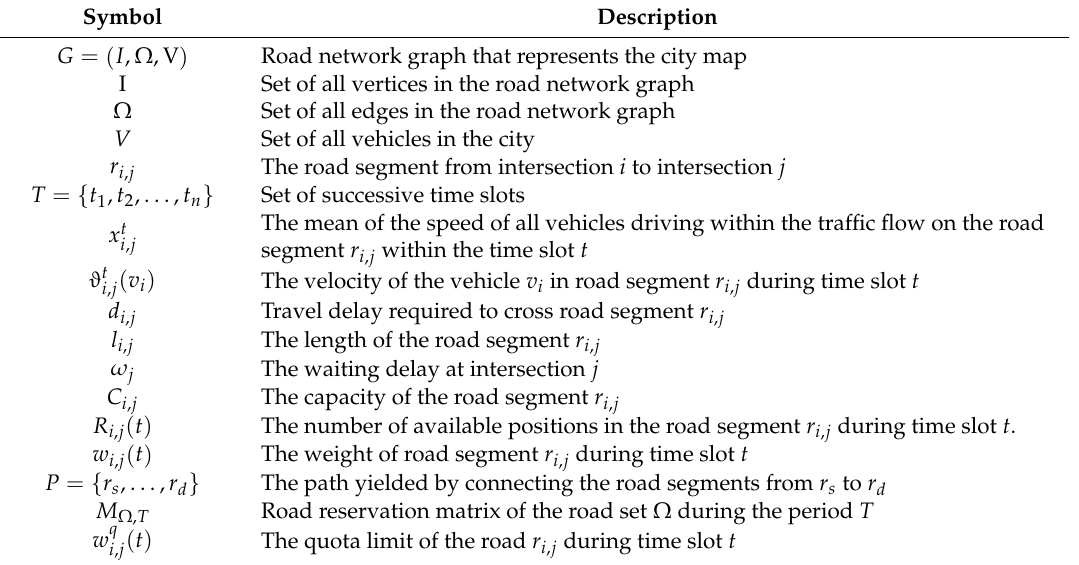
Table 2. Notations